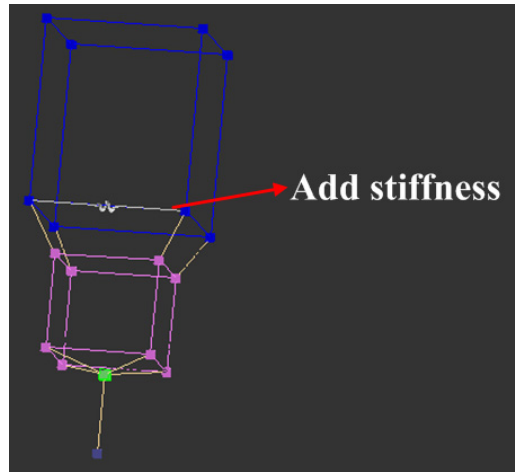
Figure 8. Adding stiffness to spindle head parts.